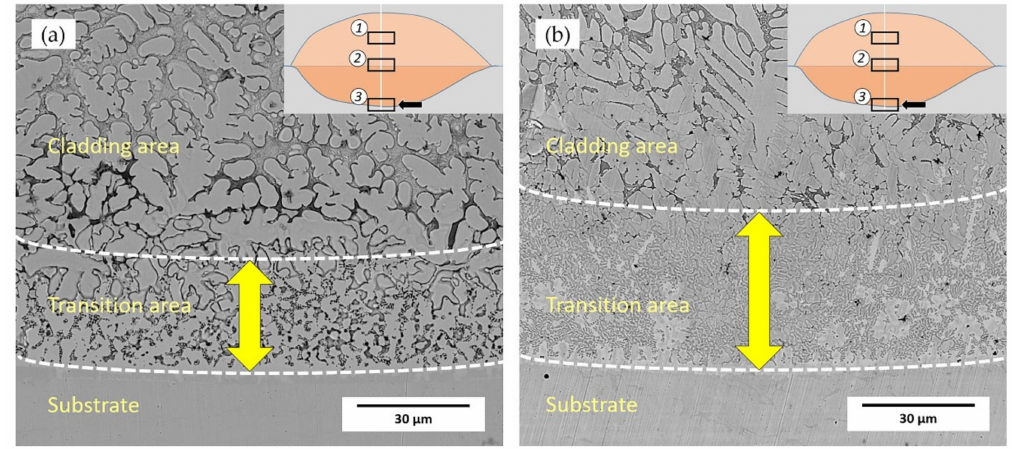
Figure 6. Microstructure of transition area in the cladding layer: ( a ) 55 NiTi powder cladding layer; ( b ) 55 NiTi + 5 Ni powder cladding